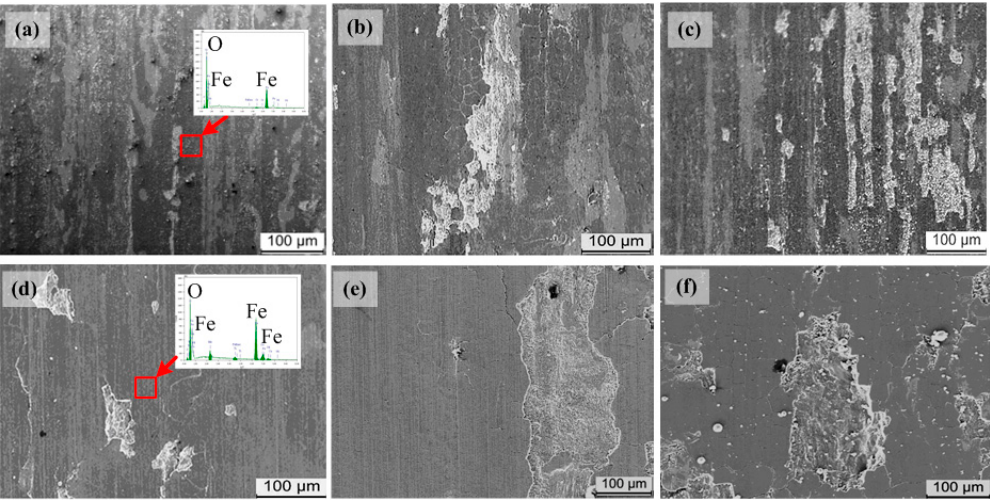
Figure 8. Morphologies of worn surfaces of 18Ni(300) maraging steel under ( a ) 100 N and 40 m/s, ( b ) 150 N and 30 m/s, ( c ) 200 N and 30 m/s, ( d ) 150 N and 60 m/s, ( e ) 200 N and 50 m/s, and ( f ) 300 N and 60 m/s.